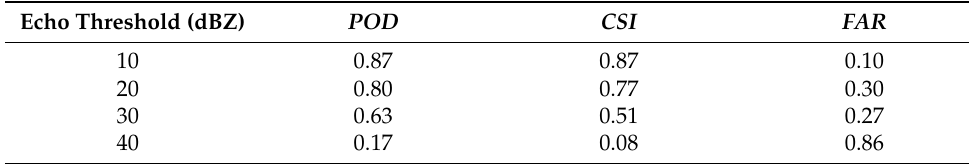
Table 2. CTREC algorithm extrapolation results at 0.5 h.